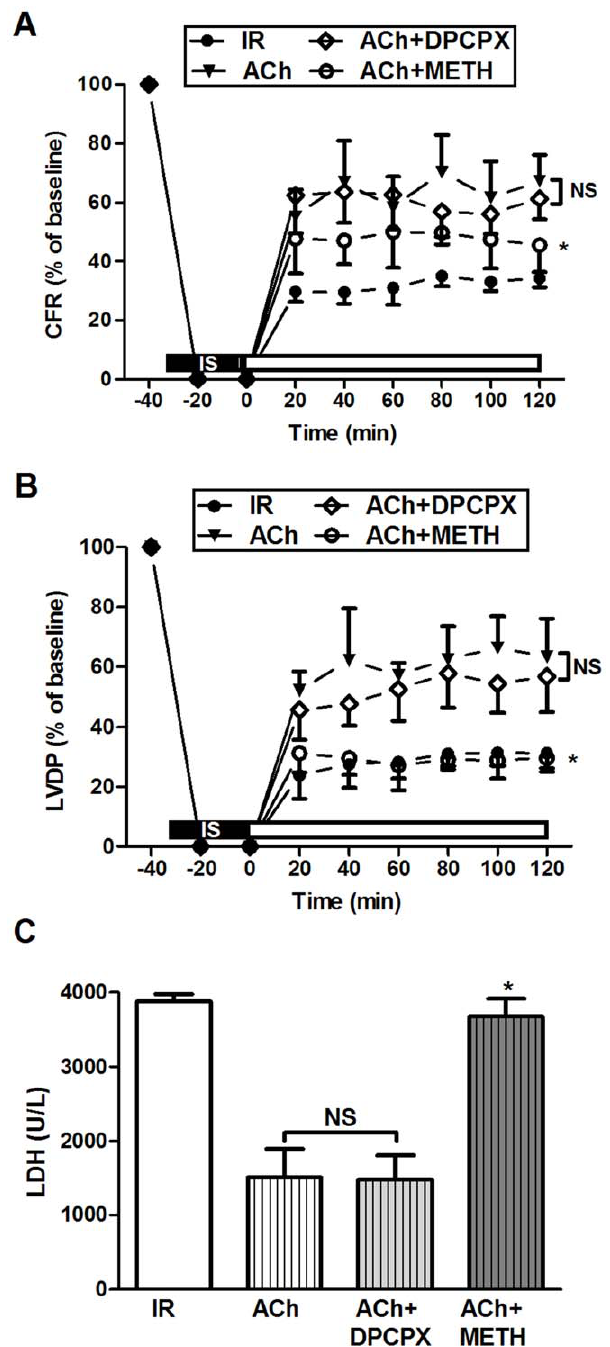
Figure 5. Effects of A 1 AR and M 2 AChR blockade on acetylcho- line-mediated cardioprotection. (A) METH abolished the increase in coronary flow rate (CFR) mediated by acetylcholine; (B) METH abolished the left-ventricular developed pressure (LVDP) improvement mediated by acetylcholine; (C) METH abolished the decrease in LDH release mediated by acetylcholine in coronary effluent. IR: ischemic reperfusion; ACh: acetylcholine; IS: iscehmia. * P , 0.05, ** P , 0.01 vs. IR; & P , 0.05, && P , 0.01 vs. ACh; NS: not significance (n=6 in each group).